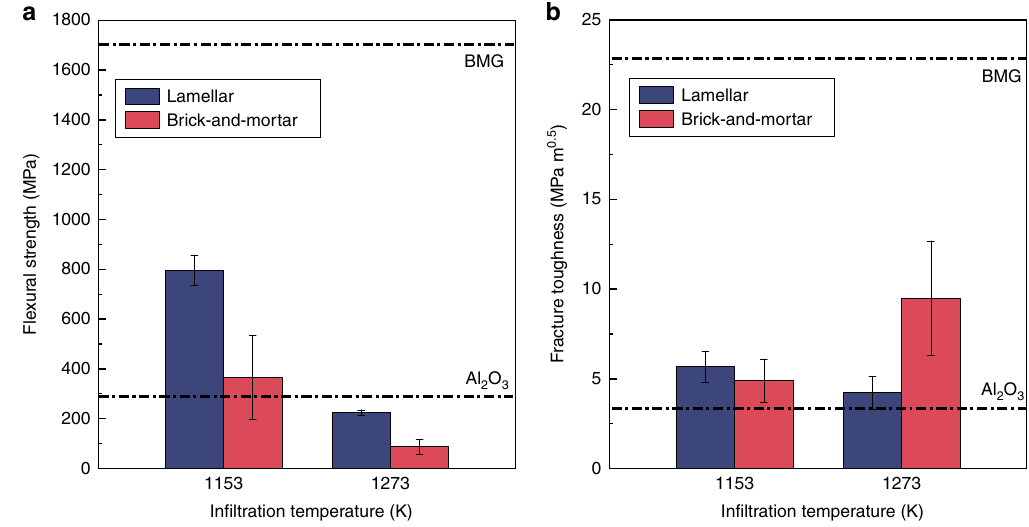
Fig. 6 Flexural strength and fracture toughness for compliant-phase ceramics. a In fl uence of in fi ltration temperature on the fl exural strength of the lamellar and brick-and-mortar samples. The strength of the samples can reach as high as 800 MPa for lamellar samples and 400 MPa for brick-and-mortar samples. While the fl exural strength is dwarfed by its BMG constituent, its strength is signi fi cantly higher than in pure alumina, the main component of the brick-and-mortar materials. This fl exural strength decreases by 75% when in fi ltrated at higher temperatures. b The fracture toughness of the brick-and- mortar materials is higher than for monolithic alumina, the main component of our compliant-phase ceramics. The marked effect of the microstructure is evident by the fact that the lamellar structures show very little change in toughness when in fi ltrated at different temperatures, whereas the brick-and- mortar samples show a large increase in fracture toughness from about 5 to 8 MPa·m ½ (with the R-curve rising as high as 14 MPa·m ½ (Fig. 7)), when in fi ltrated at higher